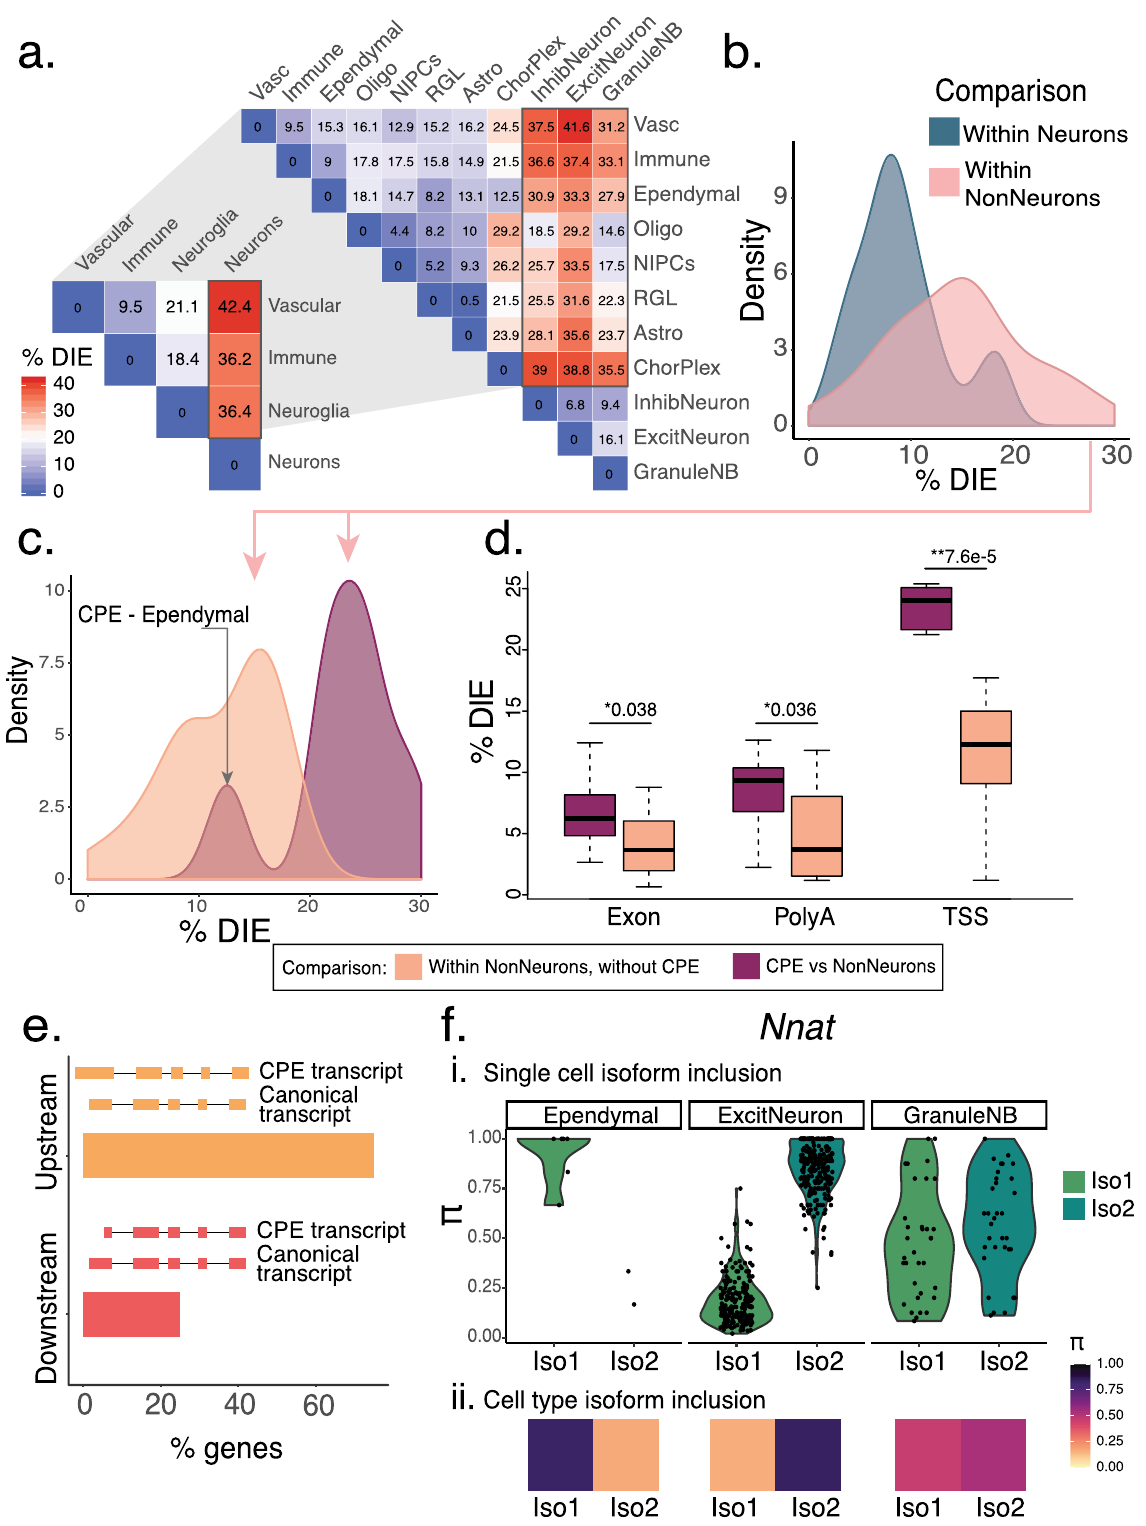
types. Conversely, the upstream-TSS isoform, Fgf13-VY, is par- tially seen in DG neuroblasts and dominates in inhibitory inter- neuron classes. This was con fi rmed using Basescope analysis with probes designed for excitatory and inhibitory neuron marker genes, and separate probes for the S and VY isoforms. We fi nd that the S isoform (pink) co-localizes with excitatory neurons (green, Neurod6 ) and not inhibitory neurons (green, Gad2 ),